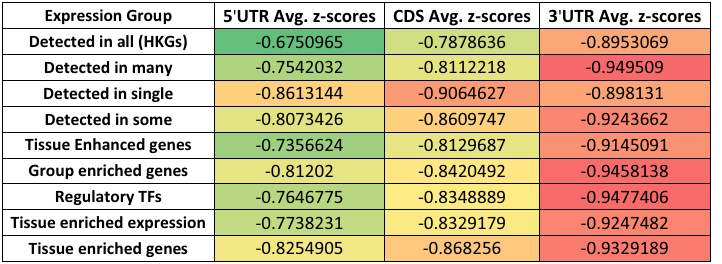
Table 2. Analysis of average per nucleotide z-score across the 5 ′ UTR, CDS, and 3 ′ UTR of differentially expressed genes in the human transcriptome.